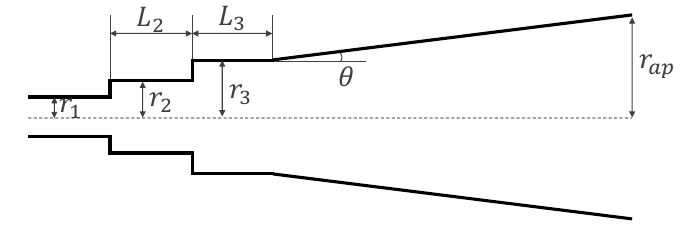
Figure 6. Representation of the Potter horn profile.